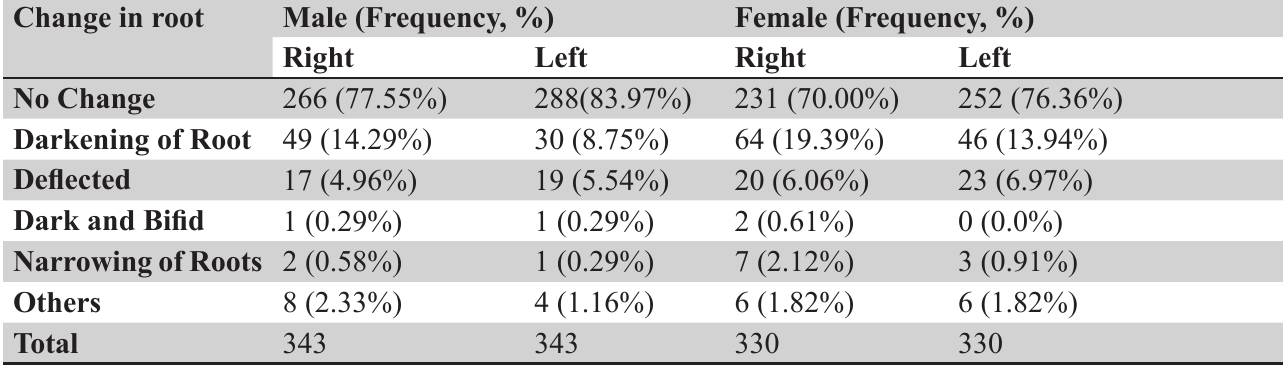
Table 1. Change in root of mandibular third molar as per